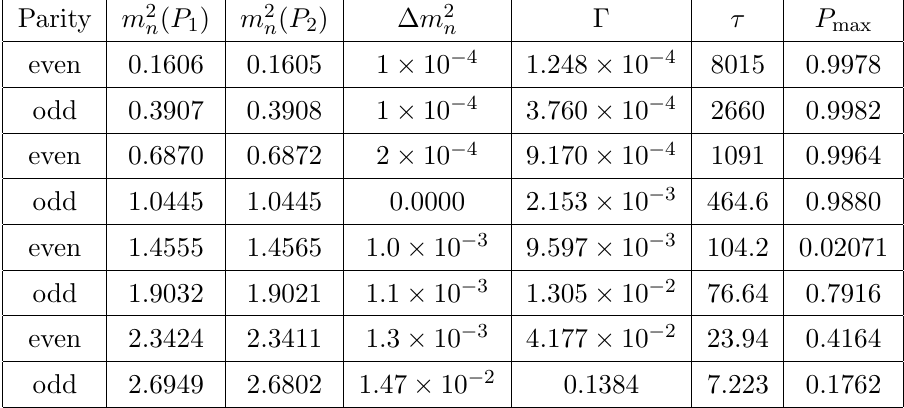
Table 2. The mass spectrum m 2 , relative probability P max , FWHM (cid:0) and life-time (cid:28) of the n resonances quasi-localized on the double brane described by (3.8).